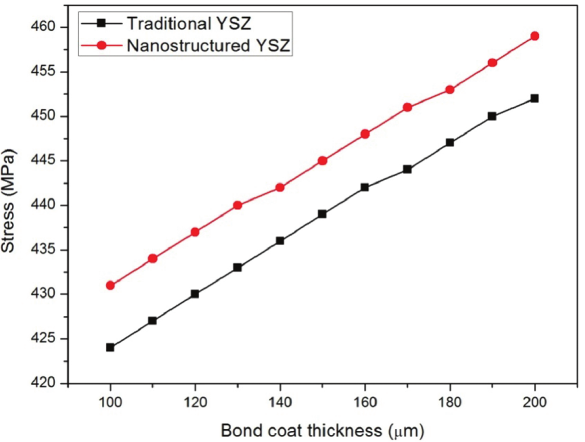
Figure 8: Shear stresses in traditional and nanostructured YSZ coat- ings as a function of BC